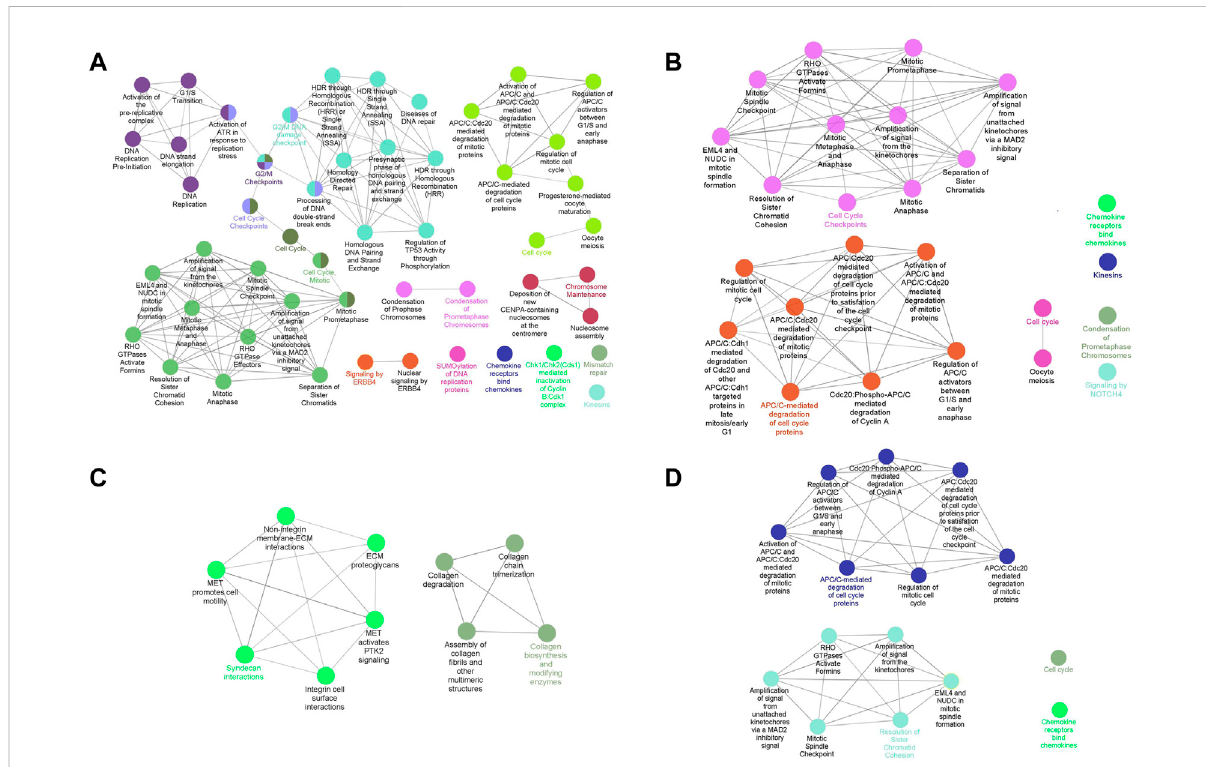
FIGURE 4 Pathway enrichment analysis of clustered genes. Interconnected and informative pathways mainly are indicated by identical colors. The most signi fi cant pathway in each network is labeled. [ (A) : TNBC vs. normal, (B) Her2 vs. normal, (C) luminal A vs. normal, and (D) luminal B vs.